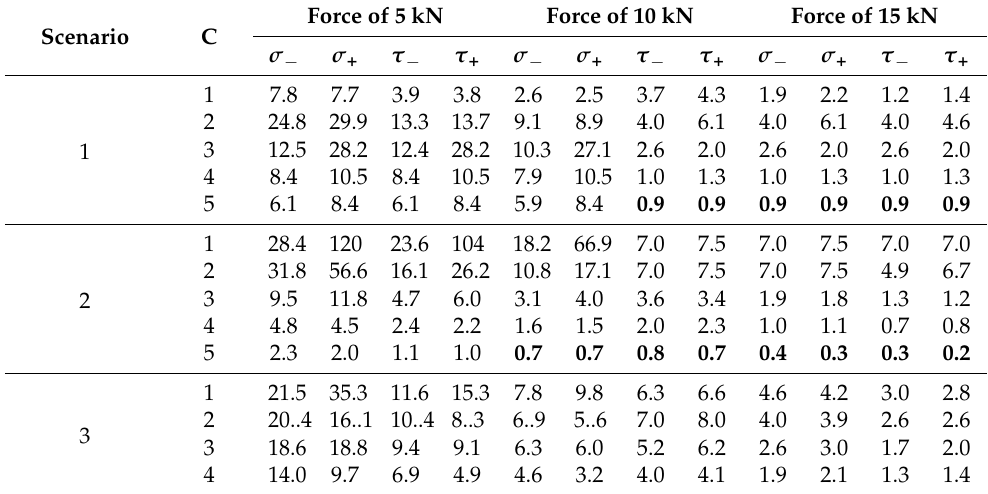
Table 9. Safety factors (relationship between load capacity and acting load) of normal and shear stresses for three horizontal load levels, three scenarios, and conditions (C) in each scenario. Force of 5 kN Force of 10 kN Force of 15 kN Scenario C σ